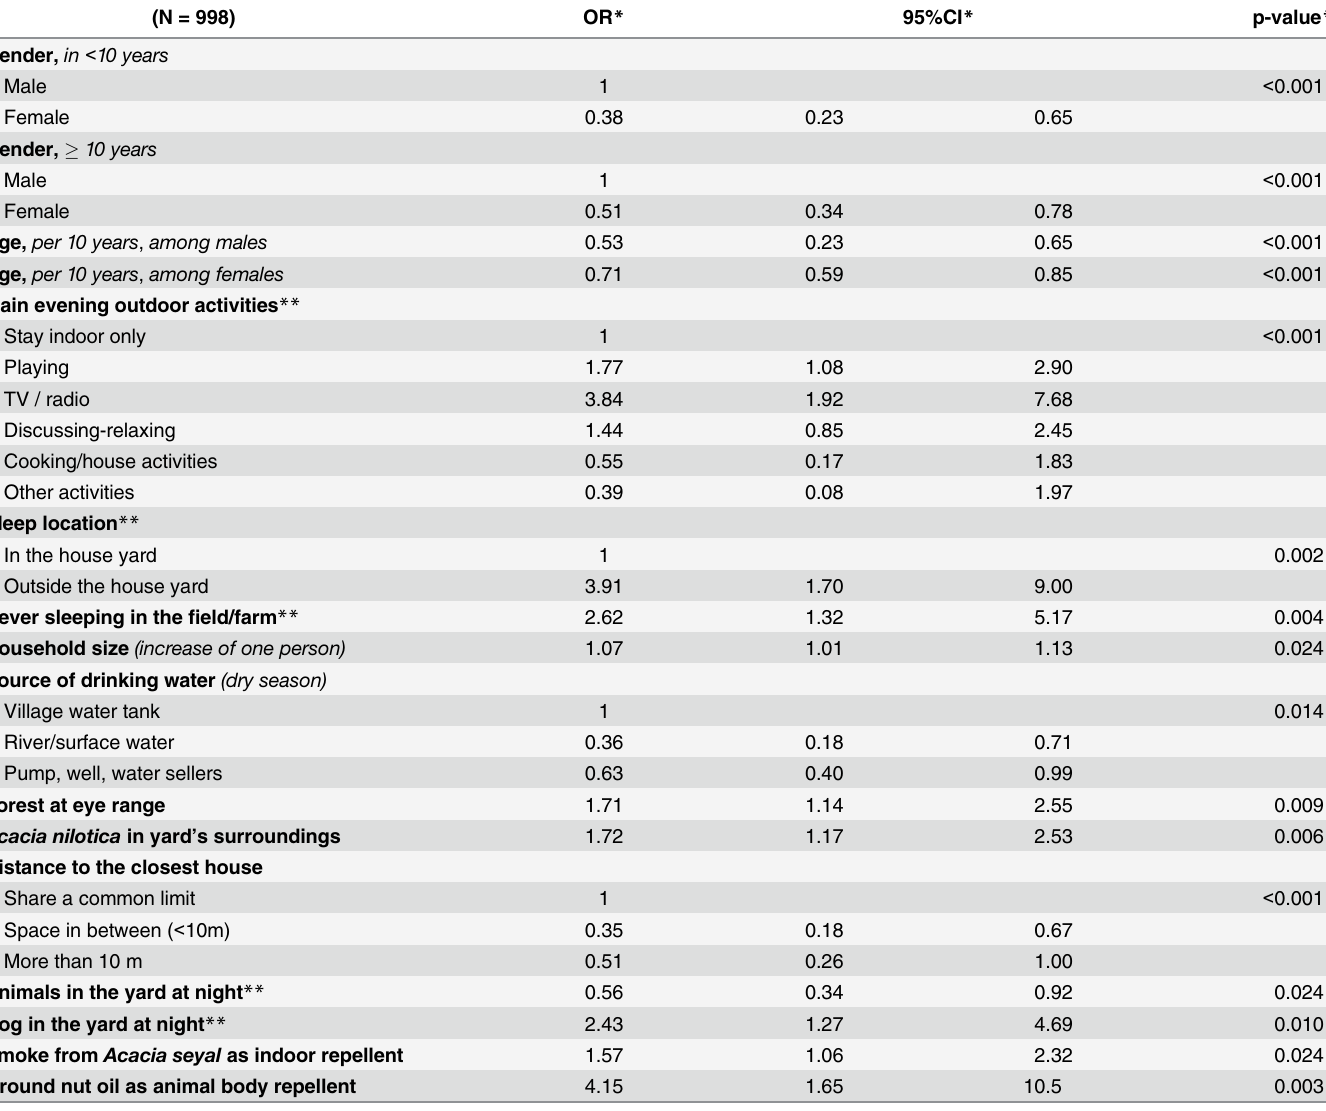
Table 3. Multivariate logistic regression mixed model of individual and household determinants for visceral leishmaniasis, with village as a ran- dom effect. Gedaref, Sudan, 2012 – 2013. (N = 998) OR * 95%CI